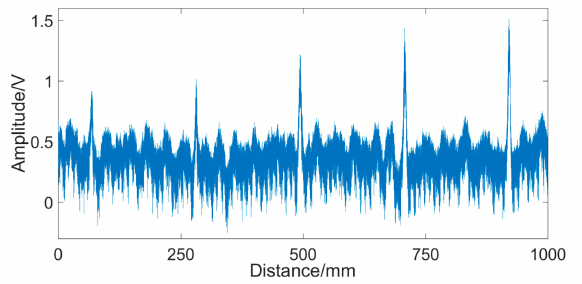
Figure 17. Signal of broken wire damage.